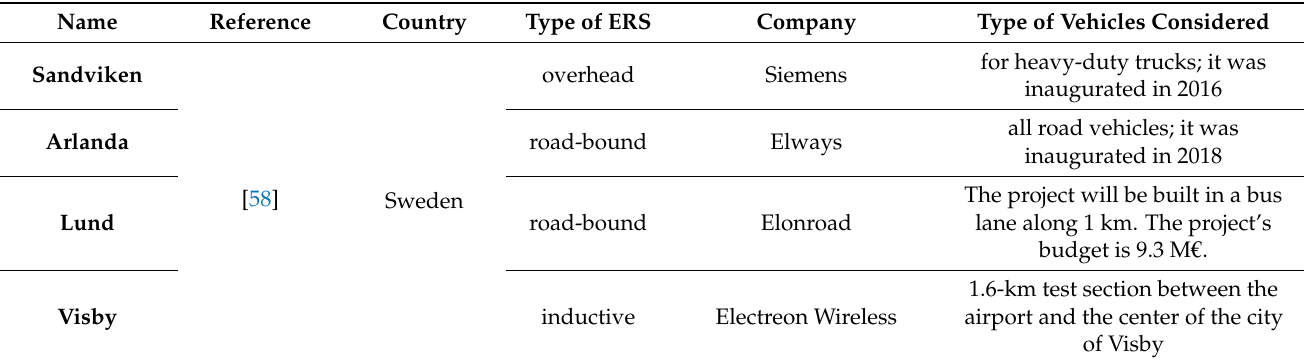
Table 1. Overview of functions in different electric road techniques